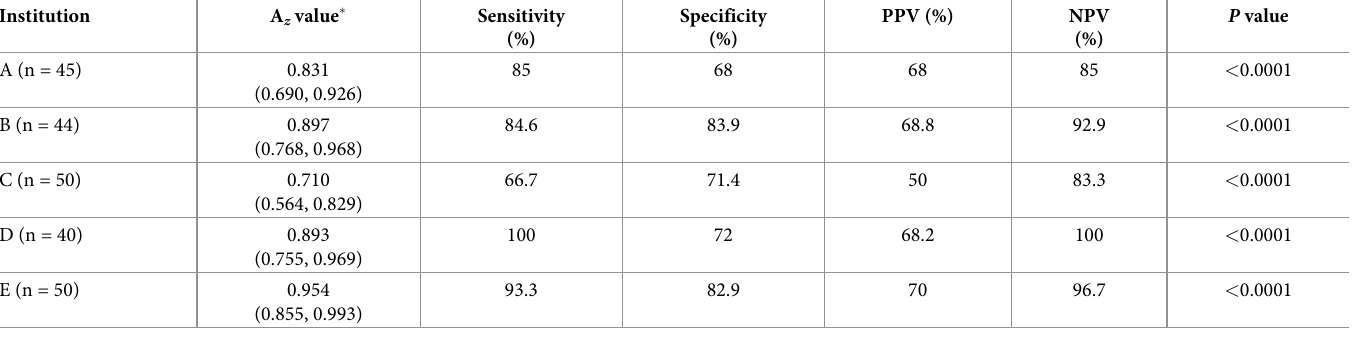
Table 6. Diagnostic accuracy of computed tomography for differentiating diffuse thyroid disease from normal thyroid parenchyma according to institution (when a cut-off “suspicious for DTD” category was selected).